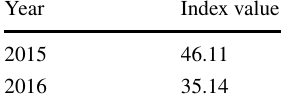
Table 7 Water quality index values for the ablation periods of year 2015 and